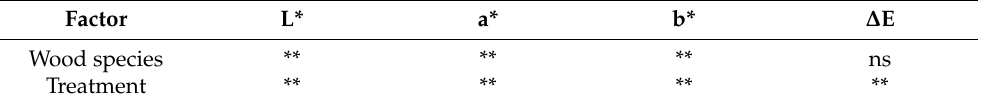
Table 6. Variance analysis summary of wood discoloration after furfurylation. Factor L* a* b* ∆ E Wood species ** ** ** ns